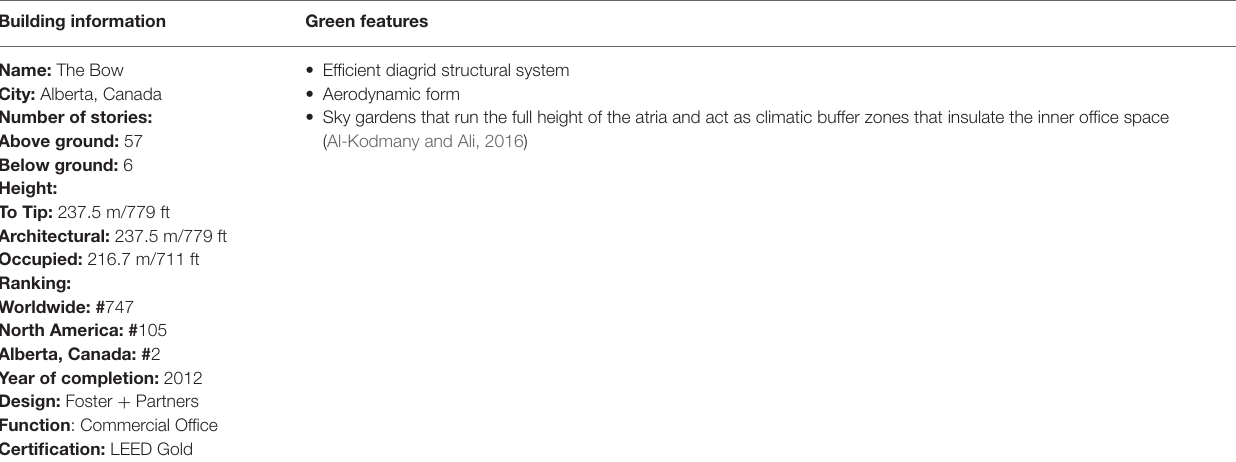
TABLE 8 | The Bow: Key green features. Building information Green